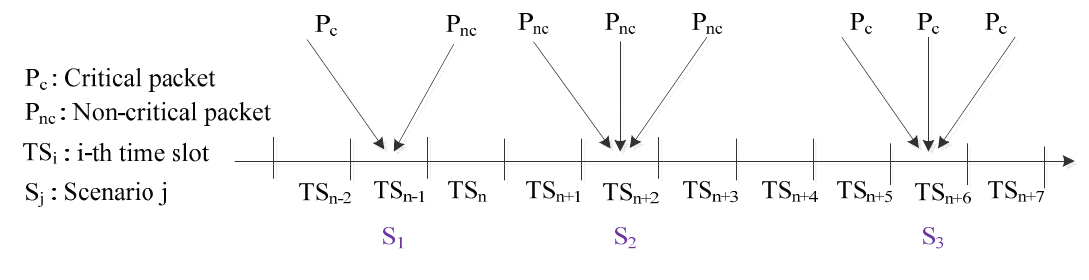
Figure 1. Collided packet transmission in cognitive radio (CR)-MAC.